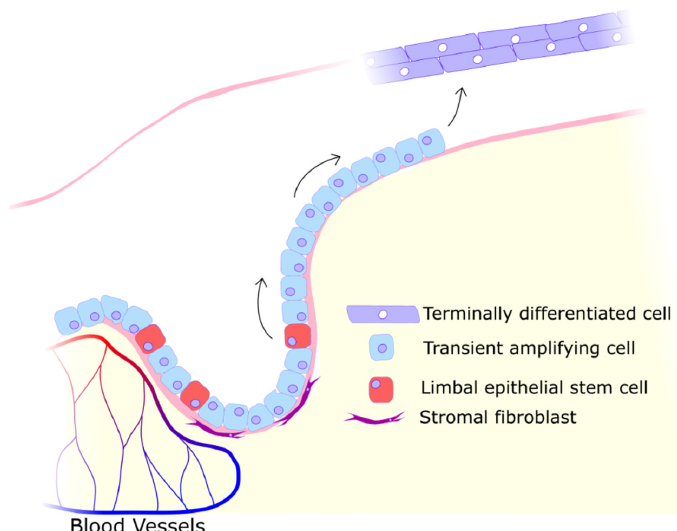
Figure 2. Limbal stem cells differentiating into migratory transient amplifying cells that migrate along the Bowman layer into the avascular central cornea to proliferate and terminally differentiate into functional epithelial cells. The limbal niche is maintained by proximity to blood vessels and secreted factors from stromal cells.